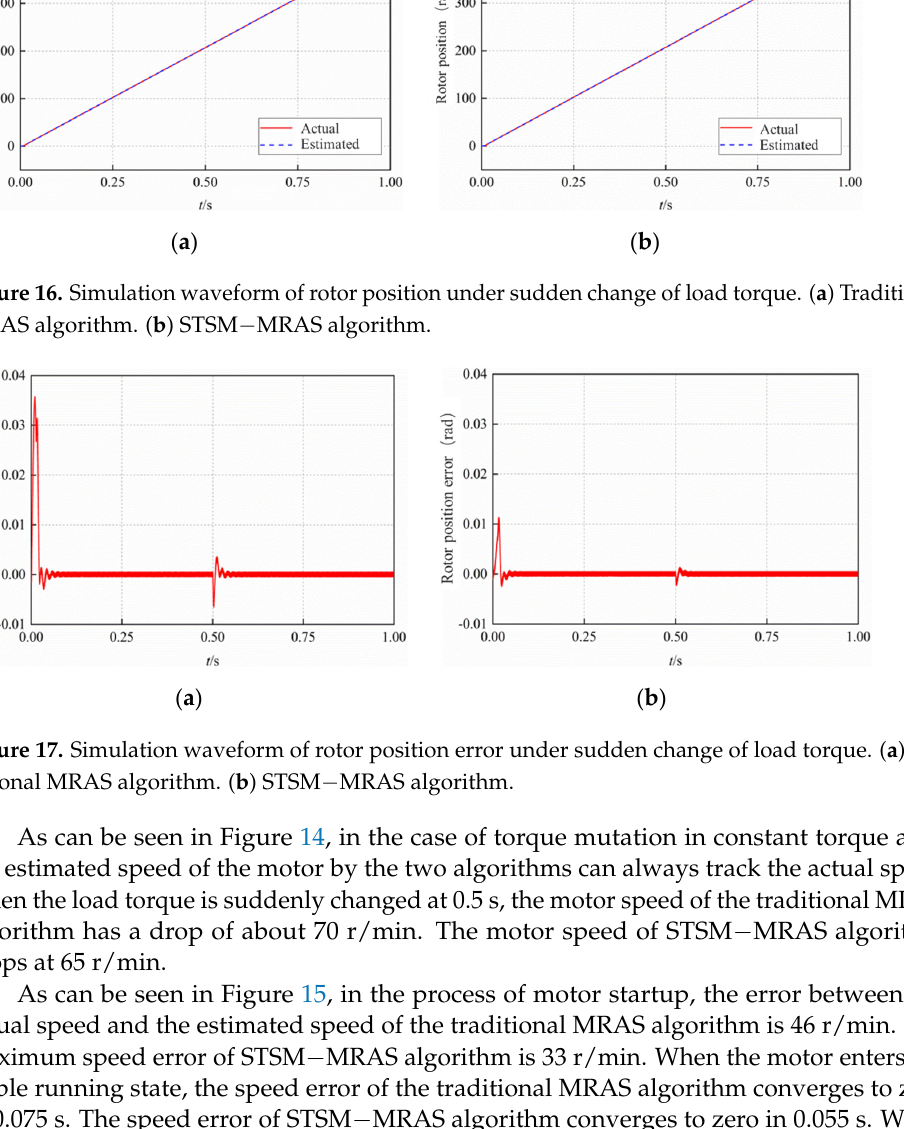
Figure 15. Simulation waveform of motor speed error under load torque mutation. ( a ) Traditional MRAS algorithm. ( b ) STSM − MRAS algorithm.